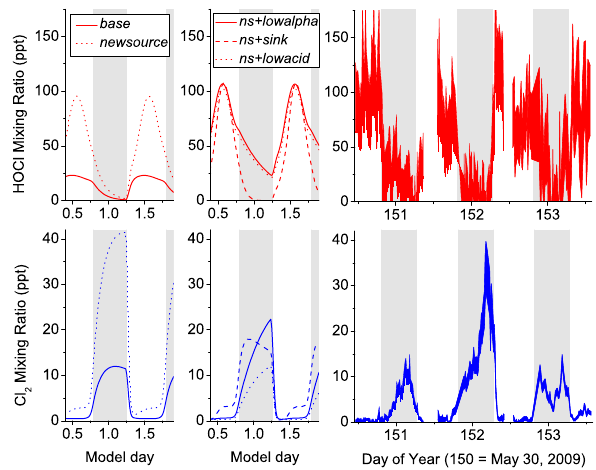
Fig. 3. Model results (left and center panels) for Cl 2 and HOCl compared to observed high Cl x period data (right panels). Observational data shaded area is within mean ± 1 standard error. Red: HOCl, blue: Cl 2 . Shaded vertical bars represent nighttime hours. Model day and day of year whole numbers are midnight.